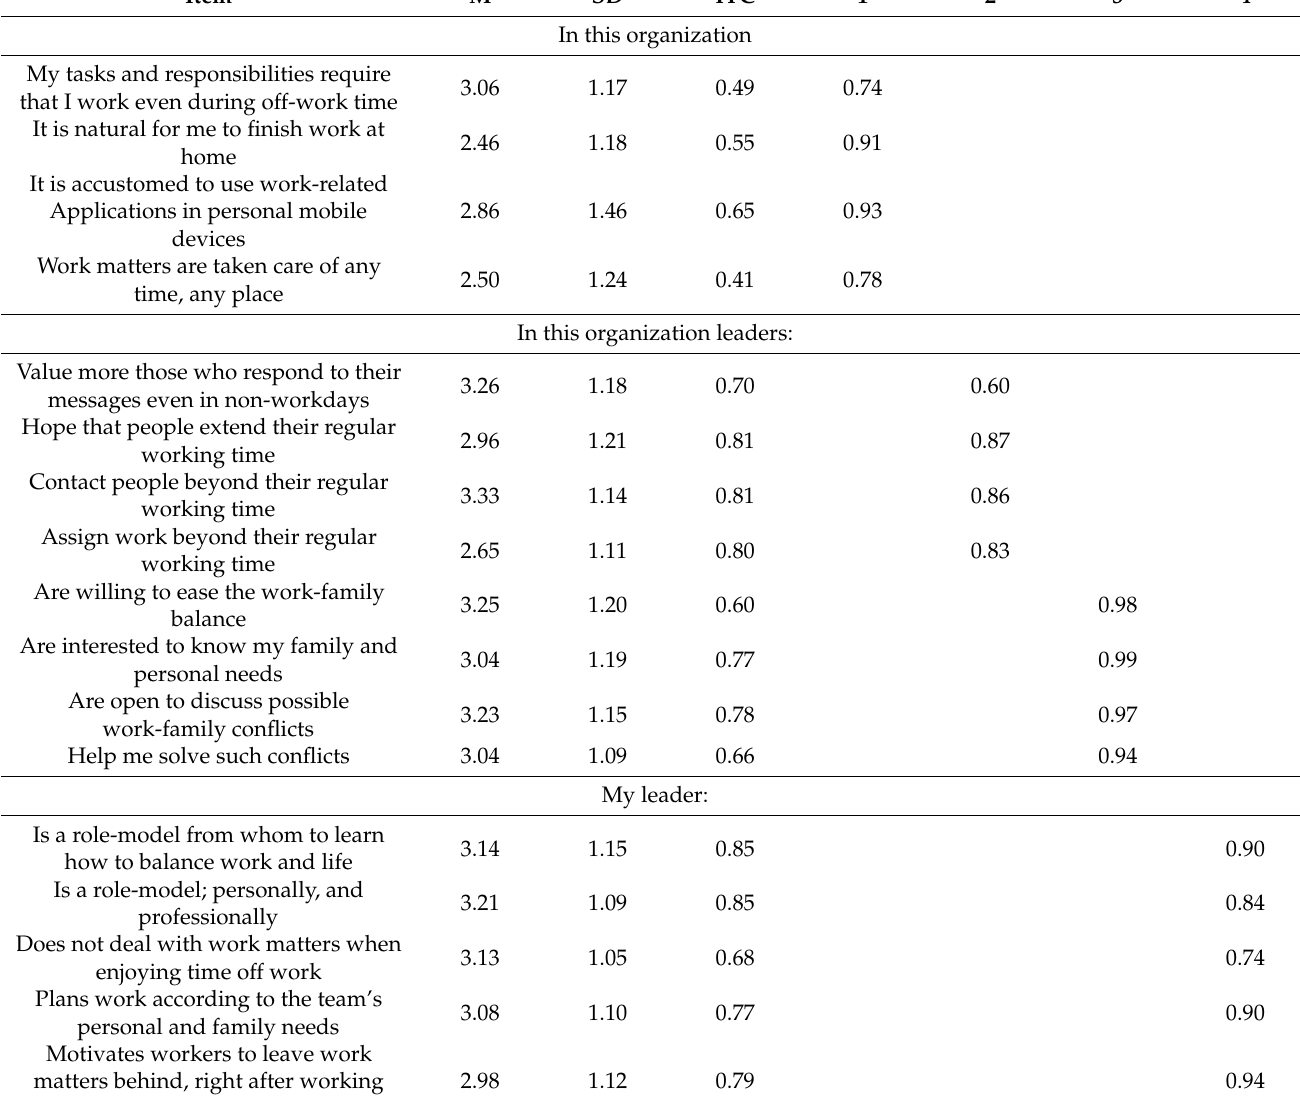
Table 1. Means, SD, corrected item-total correlation and factor